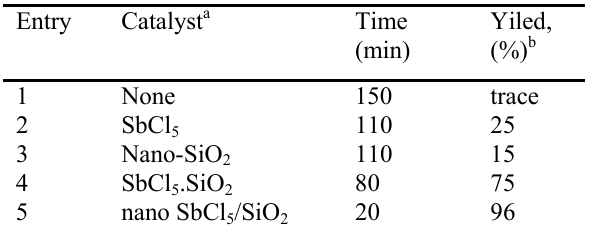
Table 1. Optimization of the model reaction using various catalysts